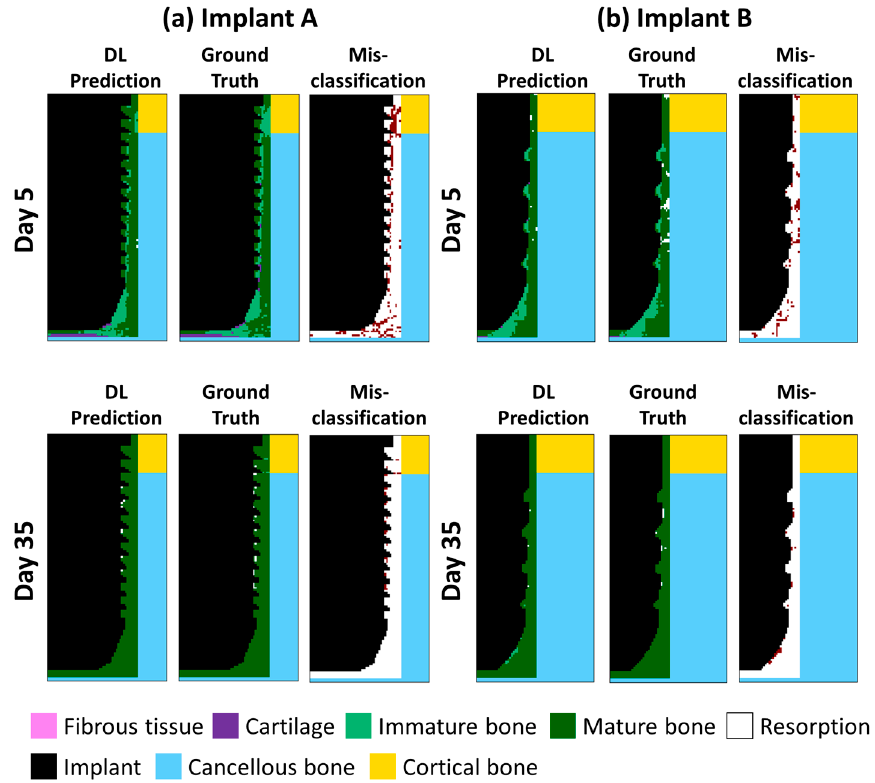
Figure 4. The results of the DLN prediction, ground truth, and the misclassification pixels of two selected implants on days 5 and 35.